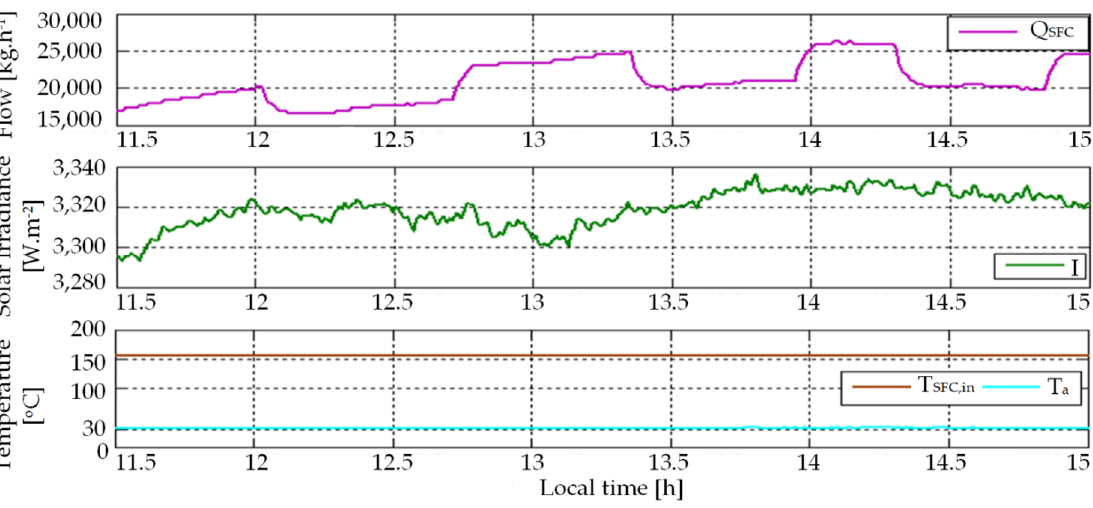
Figure 4. Simulated disturbances. The figure was changed.